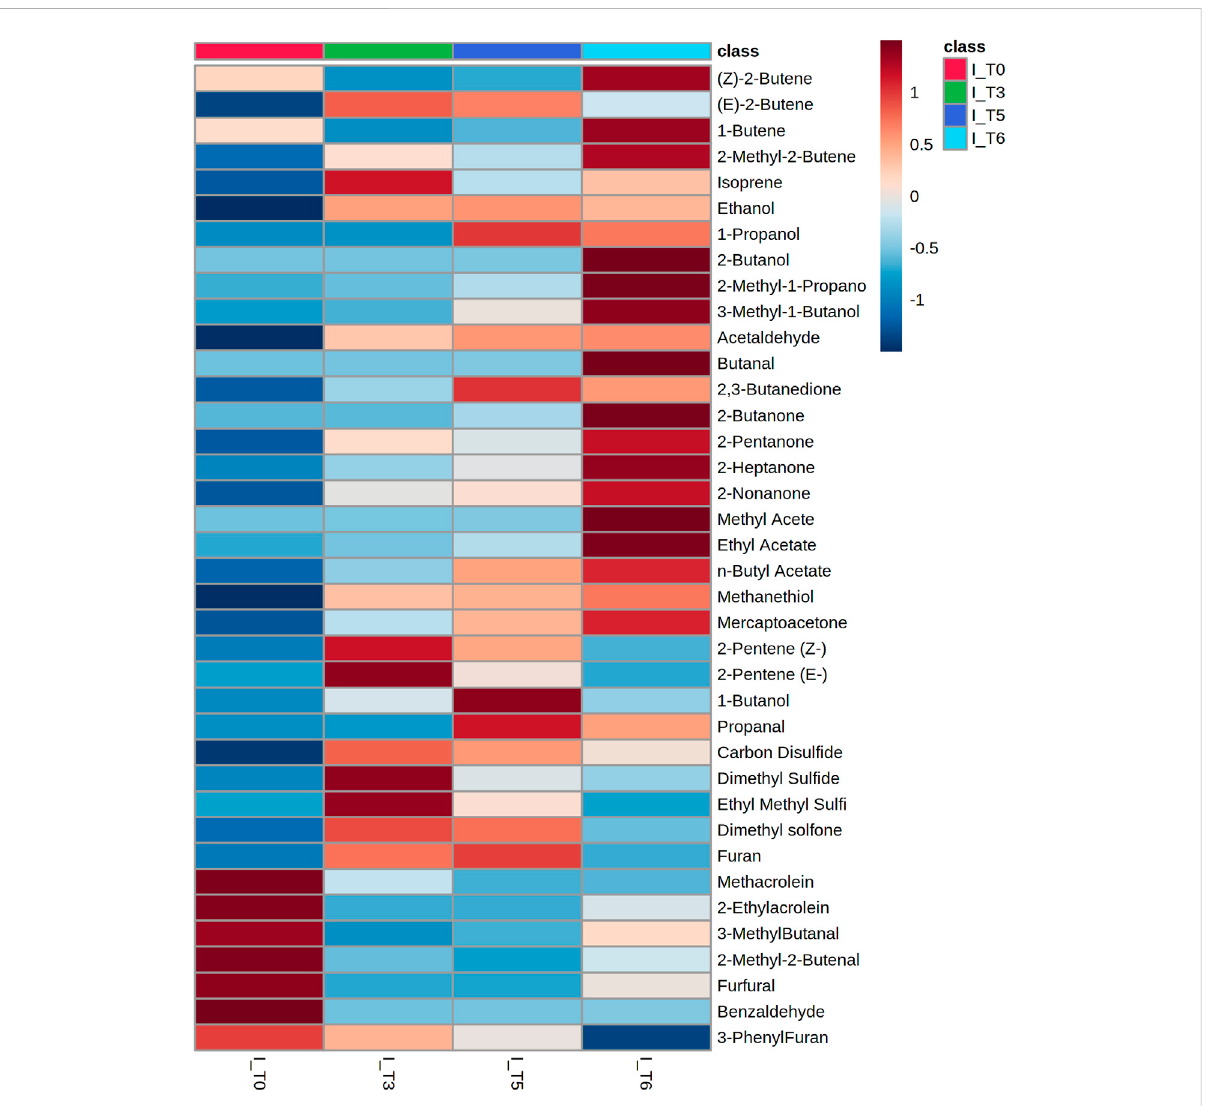
FIGURE 6 Heatmaprepresenting theaverage abundanceofallmetabolitessigni fi cantlyreleasedbyclinicalisolates ofKlebsiella pneumonia( n =19)atthe respective timepoint of bacteria